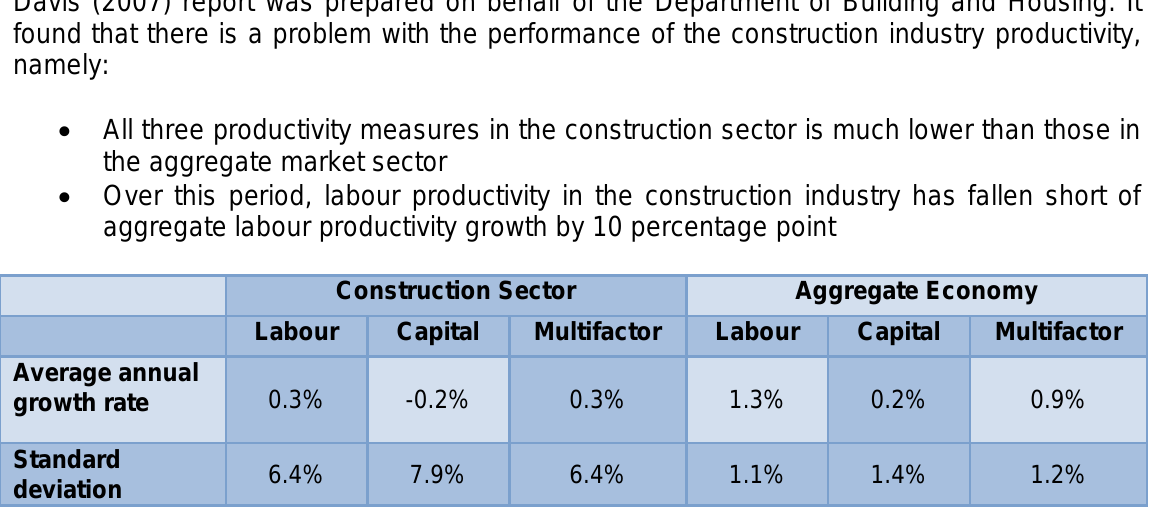
Table 2 Comparative Productivity Statistics (1997-2006) Source: Department of Building and Housing Janssen & McLoughlin (2008) is part of a series of working papers that the New Zealand Treasury aims at addressing N Z‟s long term productivity performance and factors that may be inhibiting NZ from reaching its potential; and it “examines the evidence surrounding New Zealand‟s productivity performance at an aggregate level” (Janssen et al, 2008). Table 3 shows that while of labour productivity in the 13 measured sectors considered experience an increase of 0.3% per annum, the construction industry exhibits the lowest level of growth in labour productivity, with a decrease of 3.1% per annum despite its high employment growth. The expansion of employment was mainly due to factors such as high net migration inflow, previously low interest rates, declining household sizes and infrastructure investment (Janssen, 2008). It was postulated that the possible cause for the lower-than-expected observed labour productivity growth in recent years was due to changes occurring in the NZ labour work force: “during times of high employment growth, new workers tend to dampen observed productivity growth”. This is apparently because as new workers enter employment and even if they have high levels of formal qualifications, they are generally less productive than existing workers. As a consequence, the observed productivity experiences a temporary reduction, until these workers gain sufficient job-relevant knowledge or experience, when productivity should return to its original